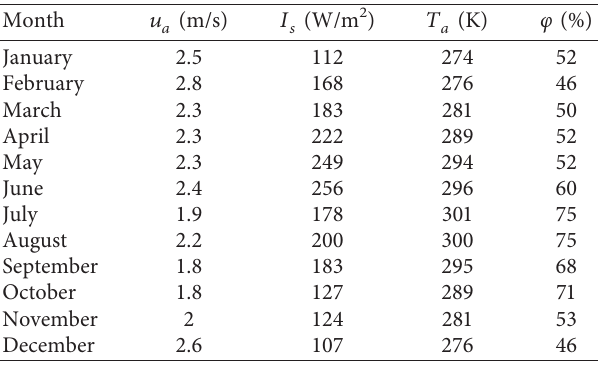
Table 2: Monthly average weather data for Daegu, South